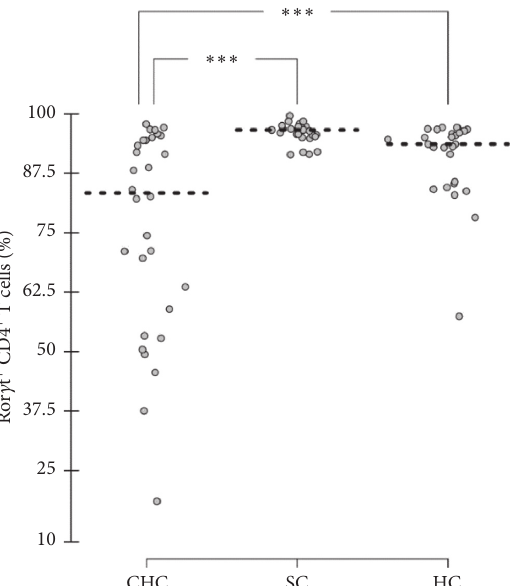
Figure 2: Percentage of CD4 + Tcells expressing Ror c t in patients with chronic hepatitis C (CHC), persons with spontaneous viral clearance (SC), and healthy controls (HC). ∗∗∗ p < 0 . 001.